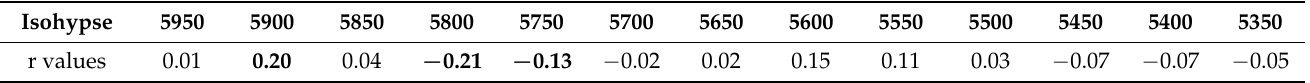
Table 2. Analysis of individual sinuosity (SIN) and SAT ( ◦ C) correlation coefficients of the 13 isohypses from 5950 to 5350 m of Z500. Bold font marks the correlations as significant (at the 95% confidence level). Isohypse 5950 r values